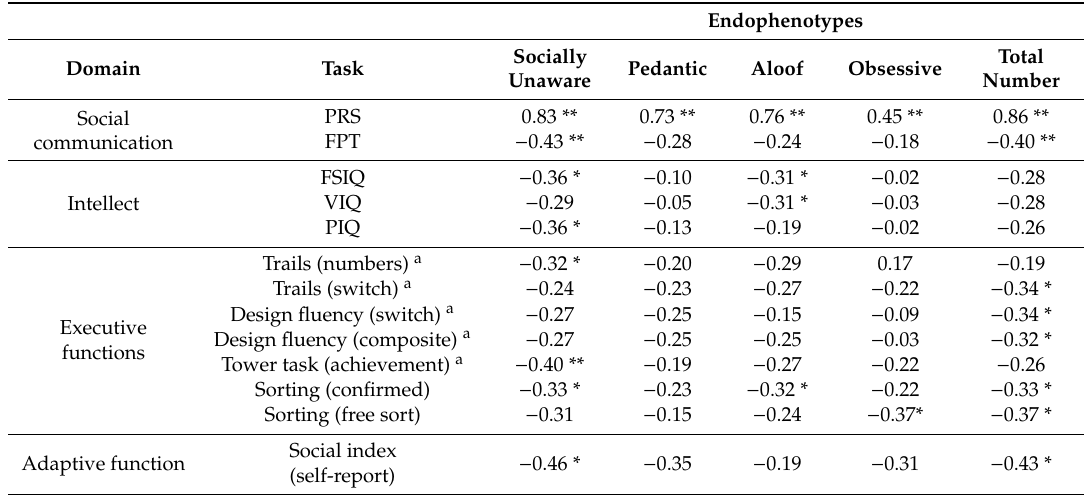
Table 3. Correlations between endophenotypes and quantitative measures in Families A and